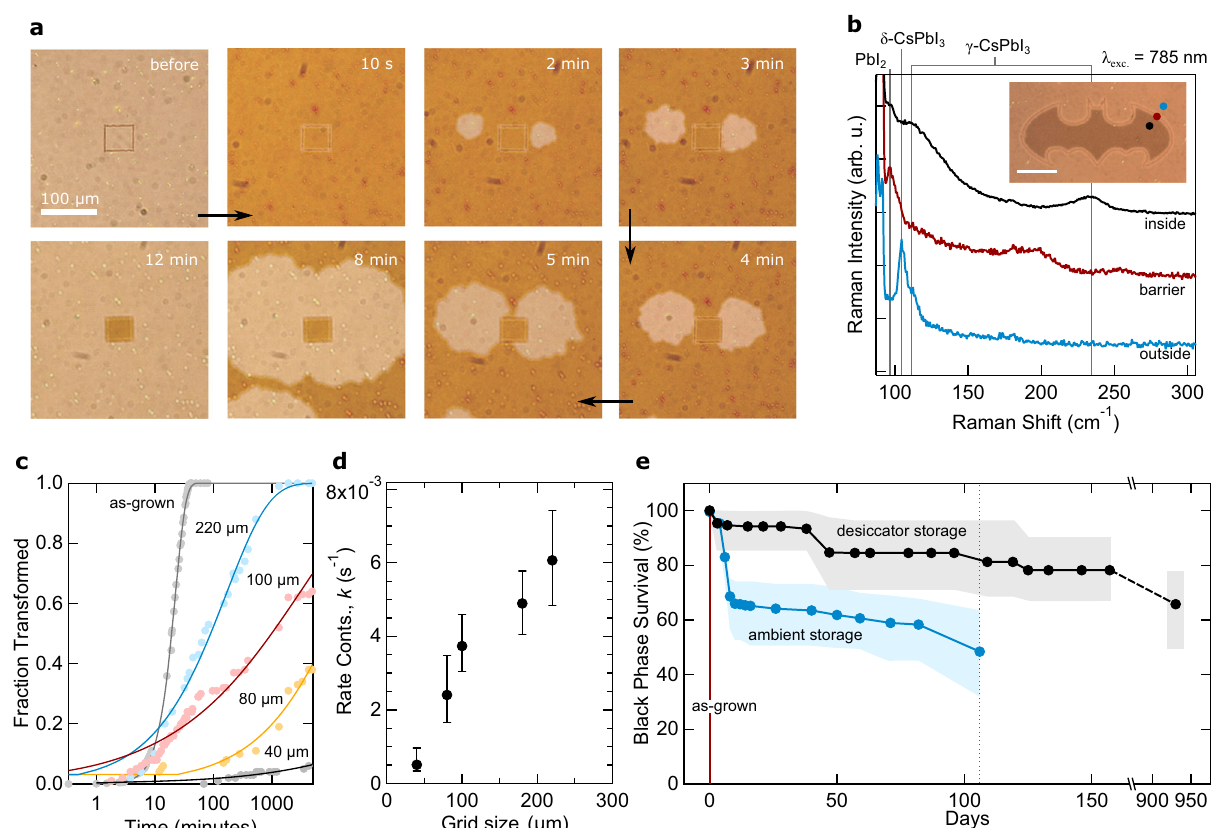
Fig. 2 | Photolithographic patterning and long-term stability of micro- processed fi lms. a Optical imaging of a microprocessed 50 μ m square before and after thermally quenching, stored under an ambient atmosphere (42%RH). The darkerregionsindicatetheblackphase,whilethegrowinglighterpartsareareasof the fi lm that have transitioned to the yellownon-perovskite phase. b Micro-Raman characterization of a phase-stable microprocessed area; micro-Raman spectra are recorded inside (black), outside (blue) and on the border (red) of the micro- processedarea,withanopticalimageofthisareaandcorrespondingmeasurement points (circles) inset. The image scale bar represents 50 μ m. The labeled vertical lines link the detected modes to their assigned chemical species. c Temporal sta- bility of black thin fi lms stored under ambient conditions (42 – 48%RH) and pro- cessed with the different grid sizes indicated. The trends (solid lines) are modeled